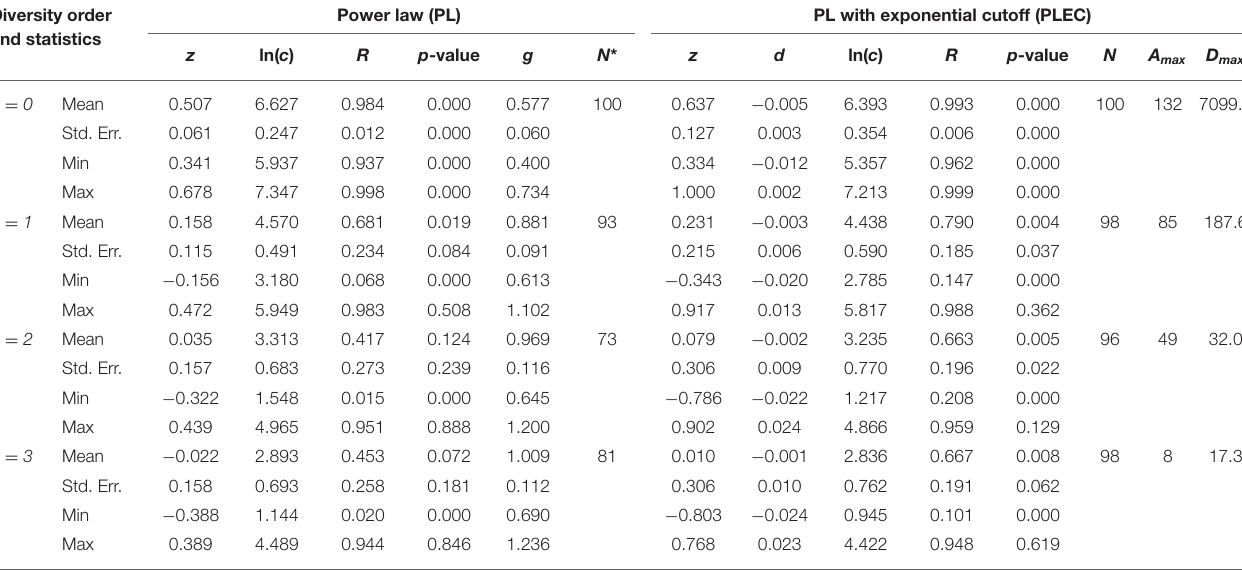
TABLE 2 | The parameters of alpha -DAR ( alpha -diversity-area relationship) computed with 100 times of re-sampling at species level for the human semen microbiome. Diversity order and statistics